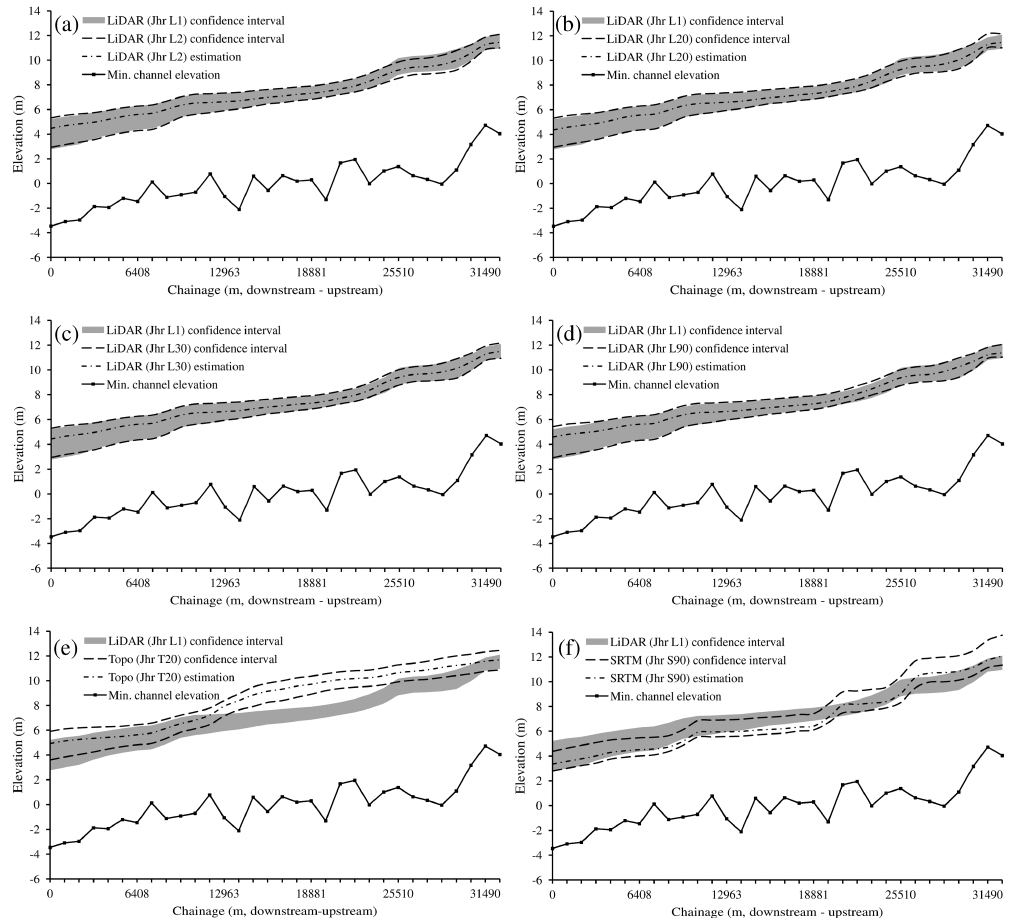
Figure 7. Comparison of uncertainty bounds (5th, 50th and 95th percentiles by considering parameter uncertainty only) between the reference model and the other models. The reference model uncertainty bounds are shown as grey areas, while the uncertainty bounds of the other six models are shown as dashed